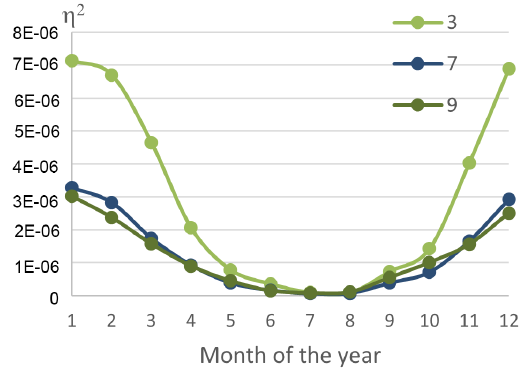
Figure 4. Influence of data series 3, 7 and 9 over the year. for each data series. According to Cohen [11], a η 2 of 0.01 indicates a small effect, whereas a η 2 of 0.14